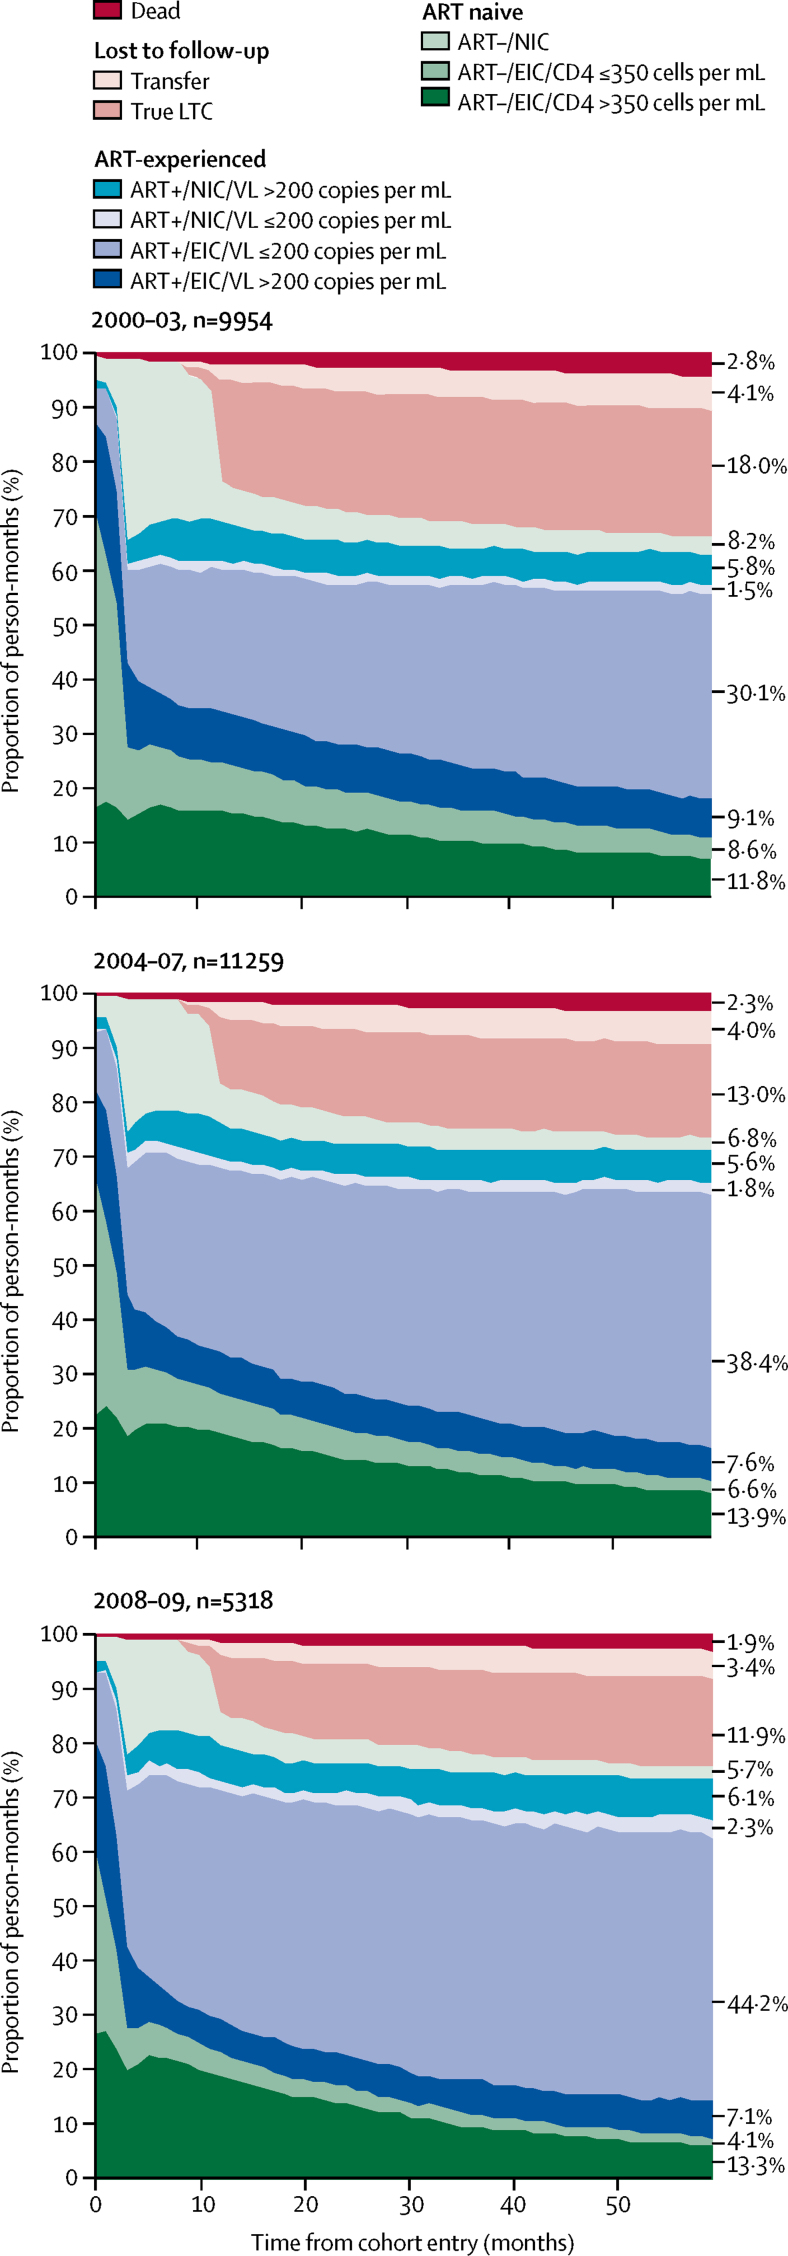
5 year longitudinal care continuum by calendar year of cohort entryPerson-months for each stage of the continuum: ART–/EIC/CD4 >350, 70 576 (2000–03), 93 695 (2004–07), and 42 573 (2008–09) person-months; ART–/EIC/CD4 ≤350, 51 350 (2000–03), 44 498 (2004–07), 13 210 (2008–09) person-months; ART–/NIC, 49 105 (2000–03), 45 749 (2004–07), 18 293 (2008–09) person-months; ART+/EIC/VL >200, 54 154 (2000–03), 51 058 (2004–07), 22 545 (2008–09) person-months; ART+/EIC/VL ≤200, 179 775 (2000–03), 259 598 (2004–07), 140 887 (2008–09) person-months; ART+/NIC/VL ≤200, 8775 (2000–03), 12 408 (2004–07), 7453 (2008–09) person-months; ART+/NIC/VL >200, 34 444 (2000–03), 38 018 (2004–07), 19 395 (2008–09) person-months; true LTC, 107 733 (2000–03), 87 975 (2004–07), 37 805 (2008–09) person-months; transfer, 24 724 (2000–03), 27 032 (2004–07), 10 713 (2008–09) person-months; dead, 16 604 (2000–03), 15 509 (2004–07), 6206 (2008–09) person-months. See appendix (p 1) for a full description of each stage of the continuum. LTC=loss to care. ART+=antiretroviral therapy experienced. ART–=antiretroviral therapy naive. NIC=not in care. EIC=engaged in care. VL=viral load.